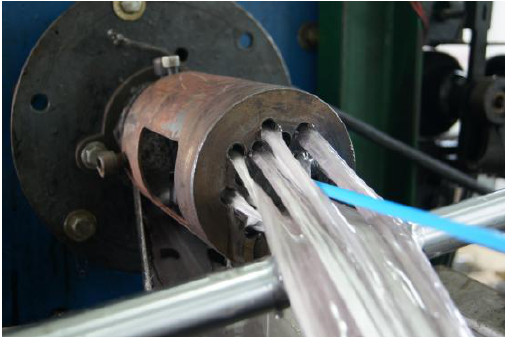
Figure 6. Tube insertion for hollow section.